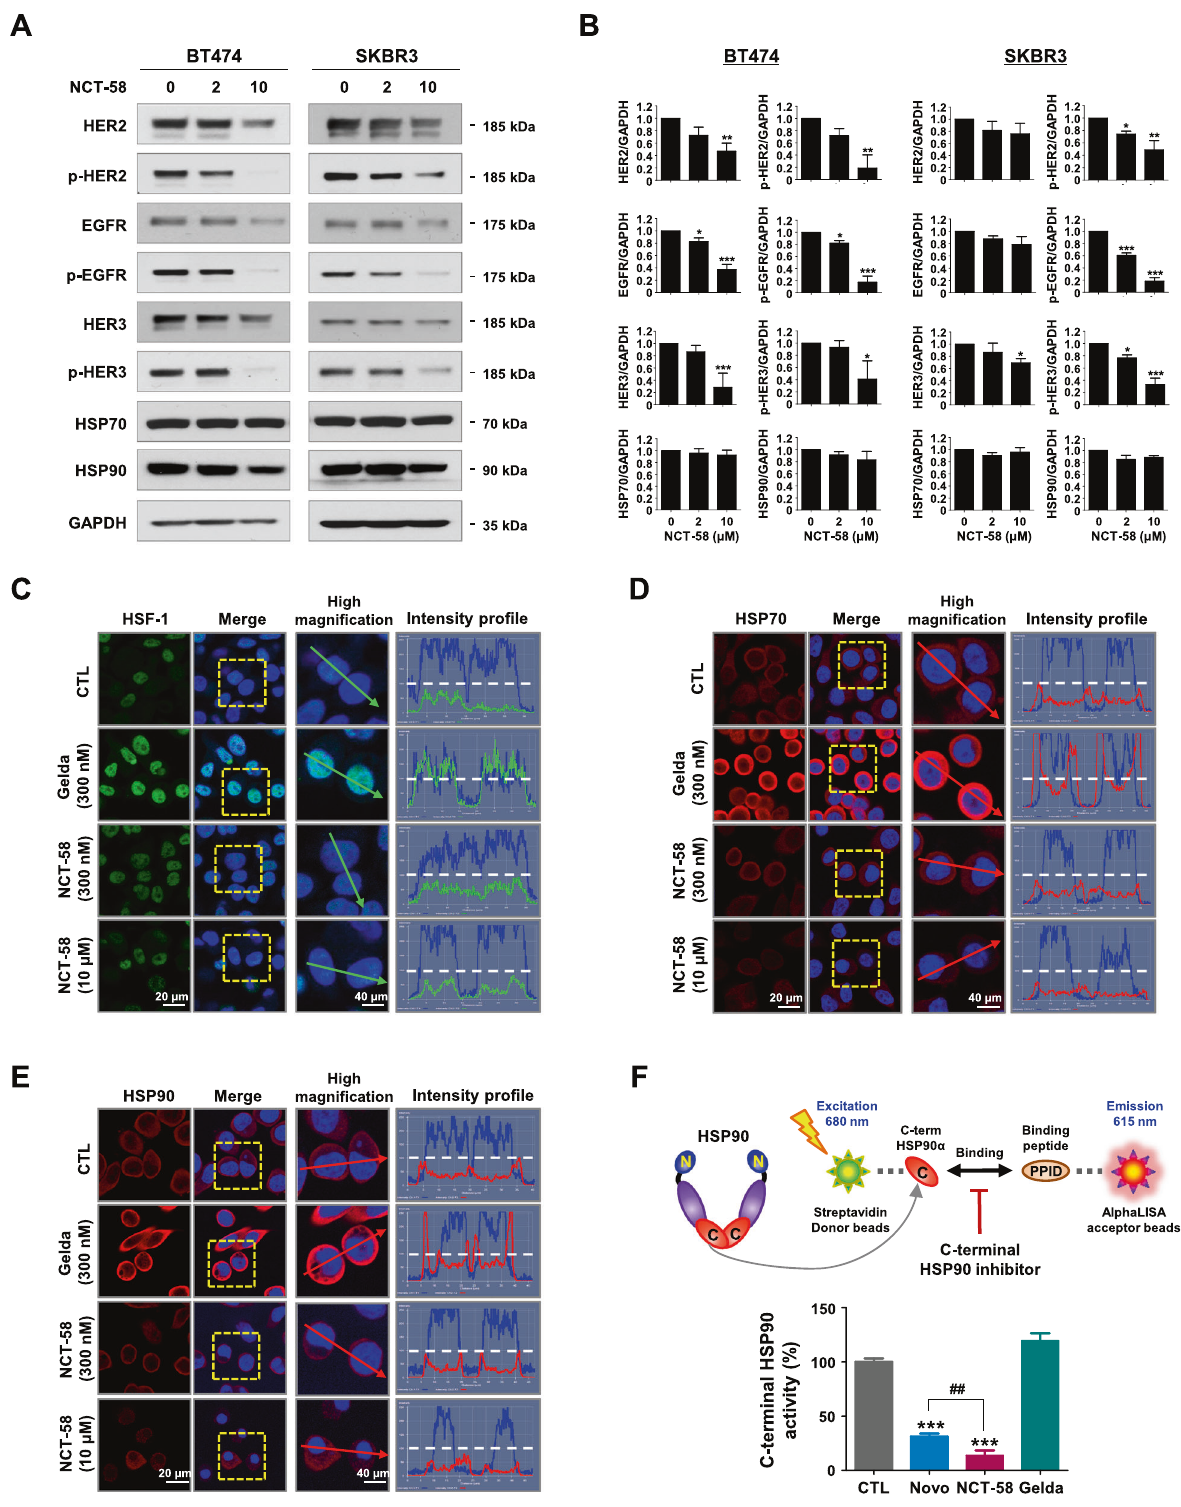
apoptotic cells (Fig. 1E). These effects were accompanied by caspase-3/ − 7 activation and PARP cleavage, as well as down- regulation of survivin (Fig. 1F, G, and Supplementary Fig. S1). NCT- 58 did not affect normal human mammary epithelial MCF10A cells, as determined by sub-G1 cell cycle analysis (Fig.